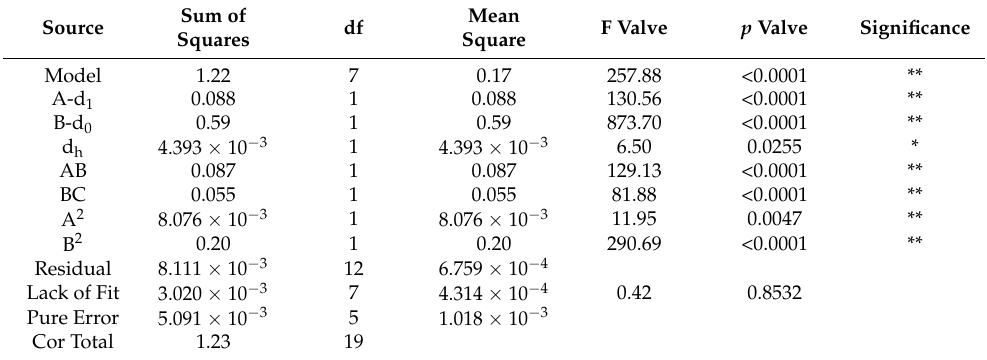
Table 7. Variance analysis of response surface quadratic model of the